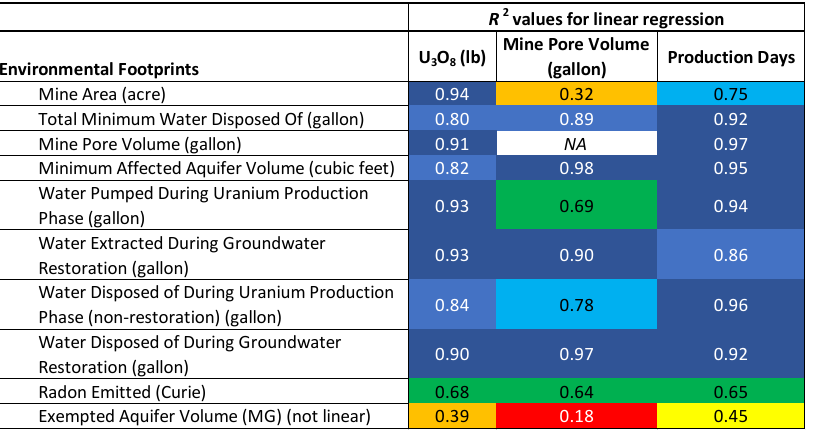
Figure 13. A heatmap of goodness-of-fit ( R 2 ) values of the linear regressions for the various environmental footprints as a function of pounds of U 3 O 8 , pore volume and production days. Cooler shades indicate higher R 2 values.